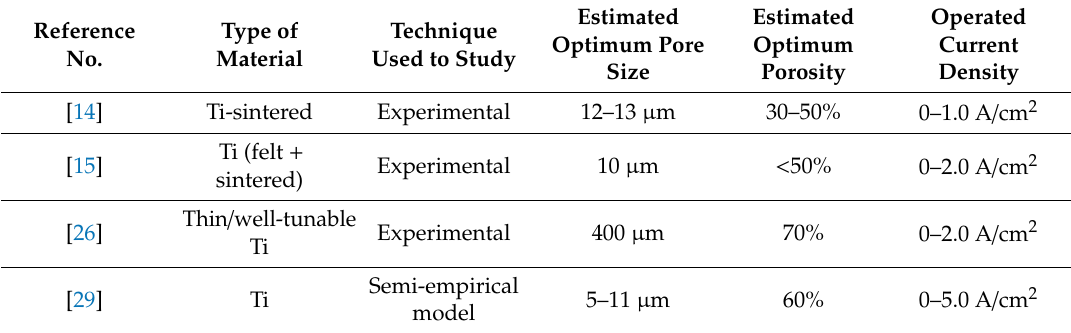
Table 1. Study of the interrelation of mass transfer limitations and porous transport layers (PTL)